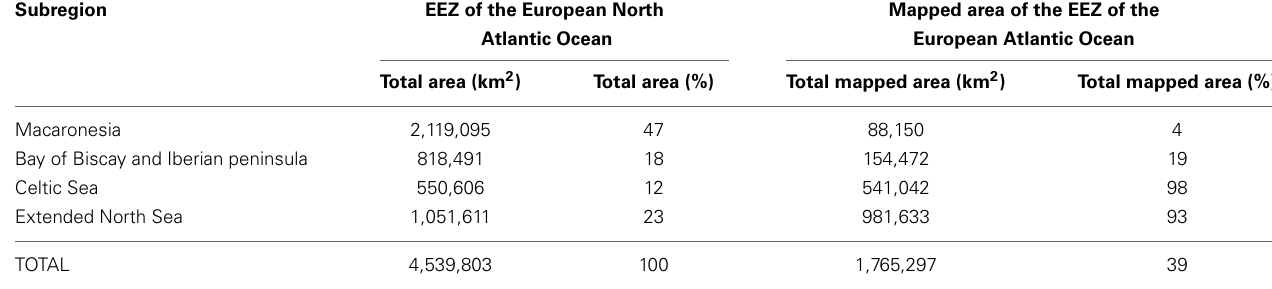
Table 1 | Total spatial contribution of each sub-region to the Exclusive Economic Zone (EEZ) of the European North Atlantic Ocean, and their mapped area, represented in total and relative (%) terms.